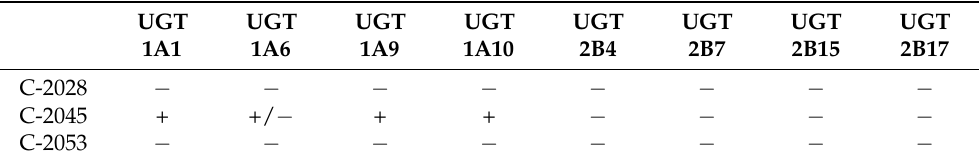
Table 4. Glucuronidation potency of the compounds C-2028, C-2045 and C-2053 (0.05 mM)